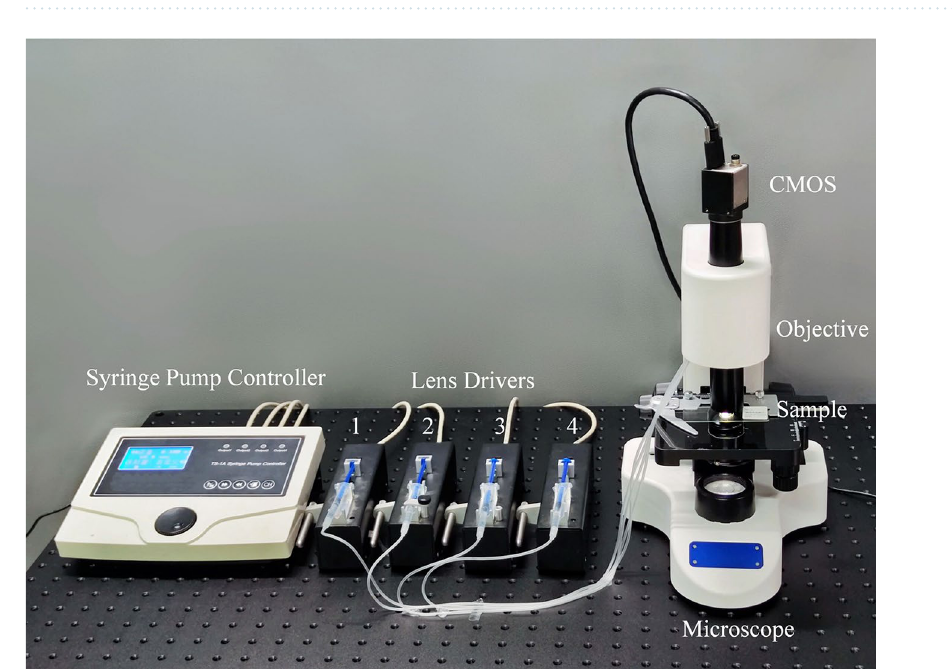
Figure 8. Experimental setup of the EDOF